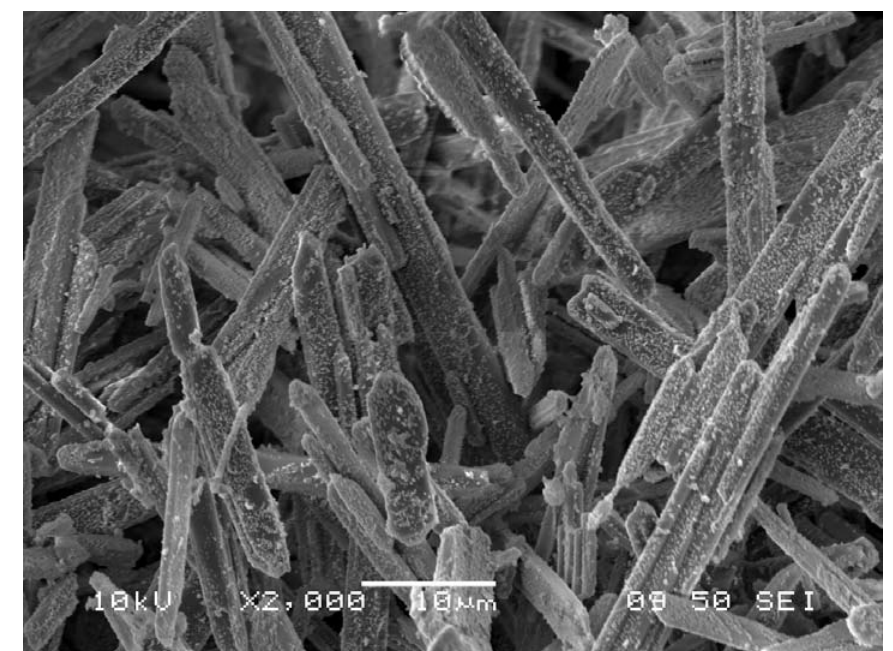
Figure 6. SEM image of sliver oxide